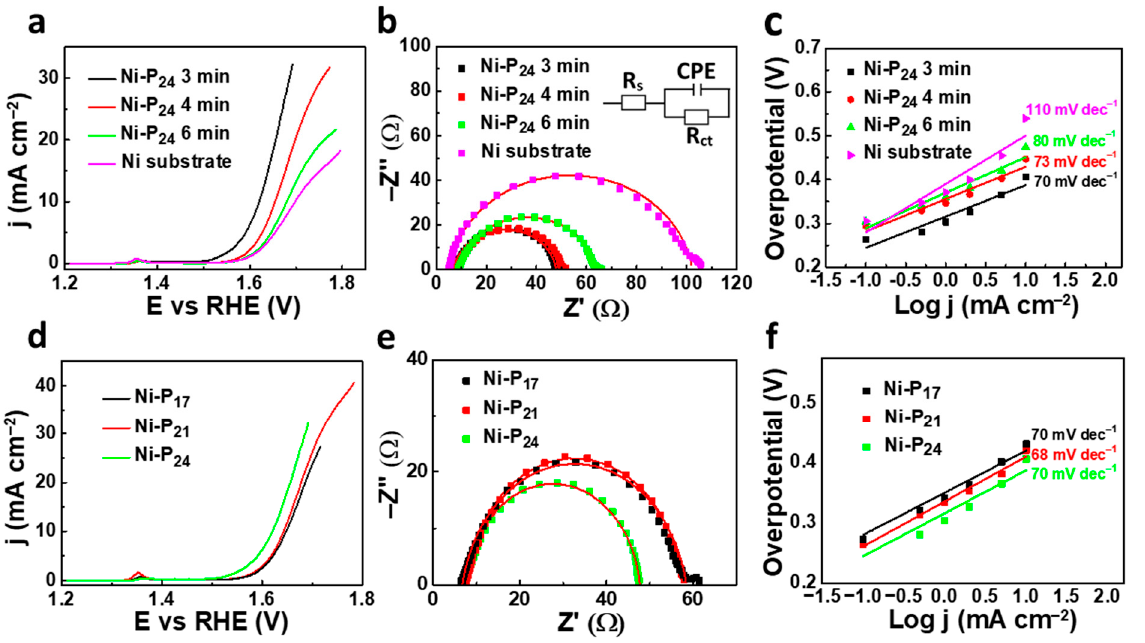
Figure 3. ( a ) Polarization curves, ( b ) Nyquist plots with the fitting curves plotted and ( c ) Tafel plots of Ni–P 24 coatings deposited at different growth times and the Ni substrate; ( d ) polarization curves, ( e ) Nyquist plots and ( f ) Tafel plots of the Ni–P coatings with different percentages of phosphorus deposited for 3 min.